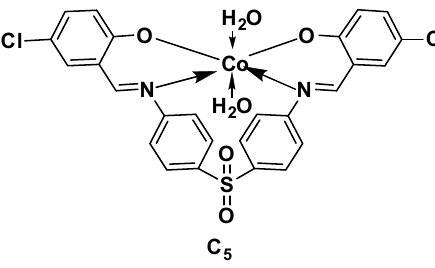
Figure 1. Proposed structure of synthesized Co(II) complexes (C 1 –C 5 ).